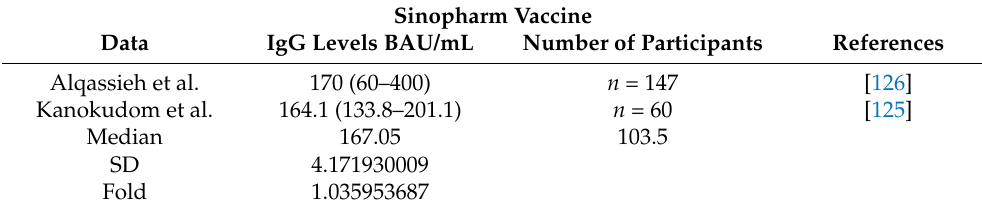
Table 4. Beneficial immune responses in inactivated COVID-19